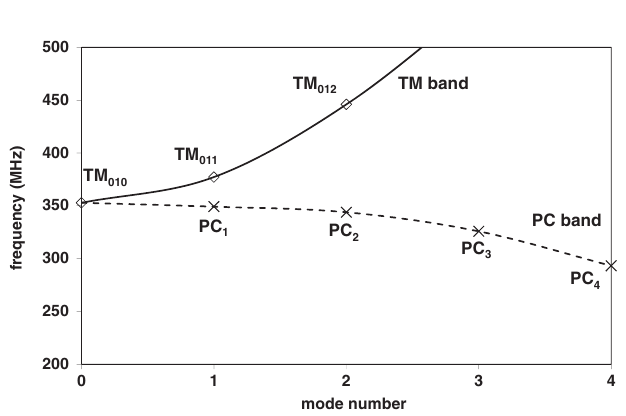
FIG. 2. TM band associated to the accelerating cells and PC band associated to postcoupler